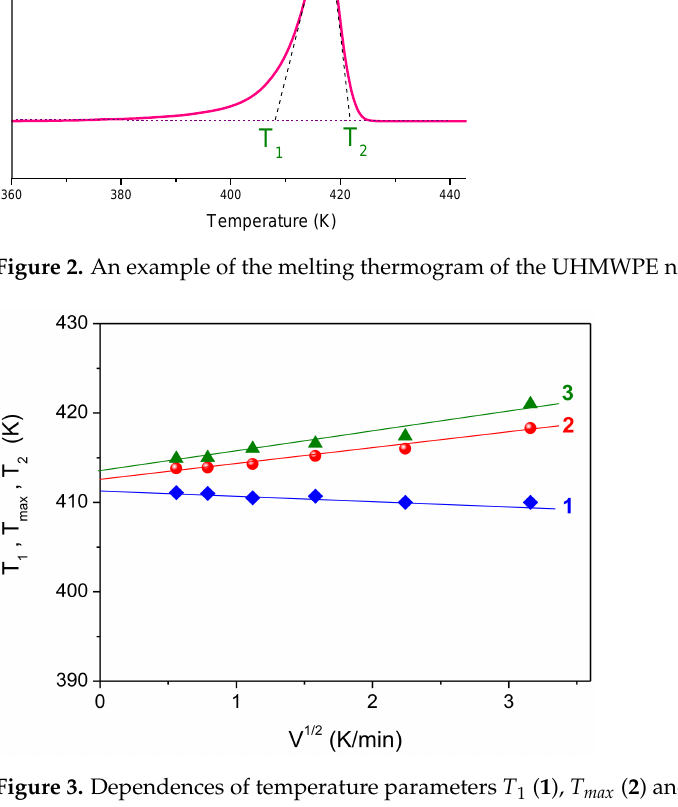
Figure 3. Dependences of temperature parameters T 1 ( 1 ), T max ( 2 ) and T 2 ( 3 ) of the melting peak of UHMWPE nascent powder samples of the same mass (6 mg) on the heating rate V 1/2 .